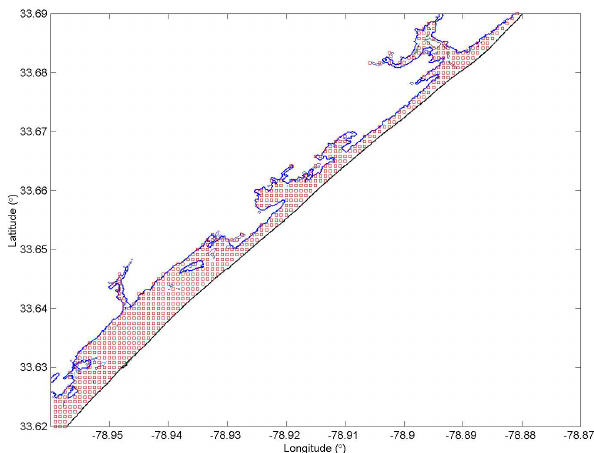
Fig. 24. Tsunami flooding in Myrtle Beach, SC: wet nodes pre- dicted in grid B21 ( (cid:3) ) and maximum inundation computed in grid C21 (—).